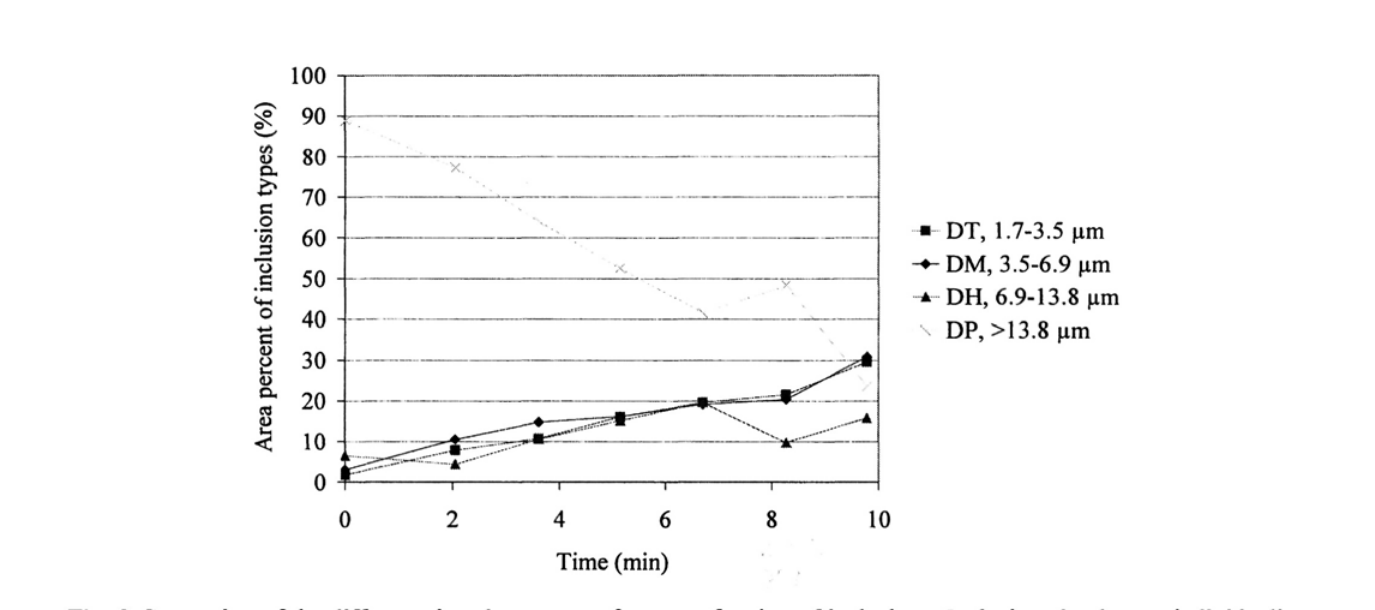
Fig. 8: Proportion of the different size classes to surface-area fraction of inclusions. Inclusions in clusters individually